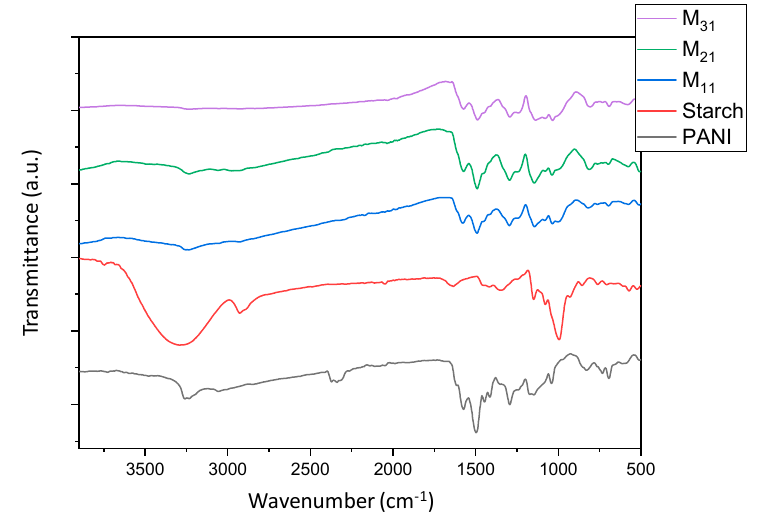
Figure 3. FTIR-ATR spectra of PANI, starch, and PANI/starch biocomposites. The residual CO 2 signal may be due to the adsorption properties of PANI.